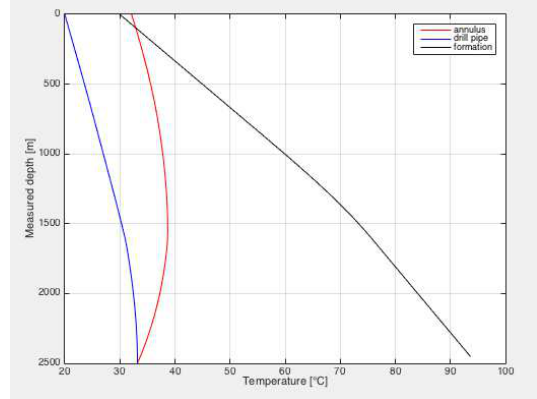
Figure 12: Temperature distribution- viscosity : 100 cP model for drilling fluids leads to lower viscosity val- ues and consequently an overestimation of the CHTC and the maximum temperatures in the wellbore.